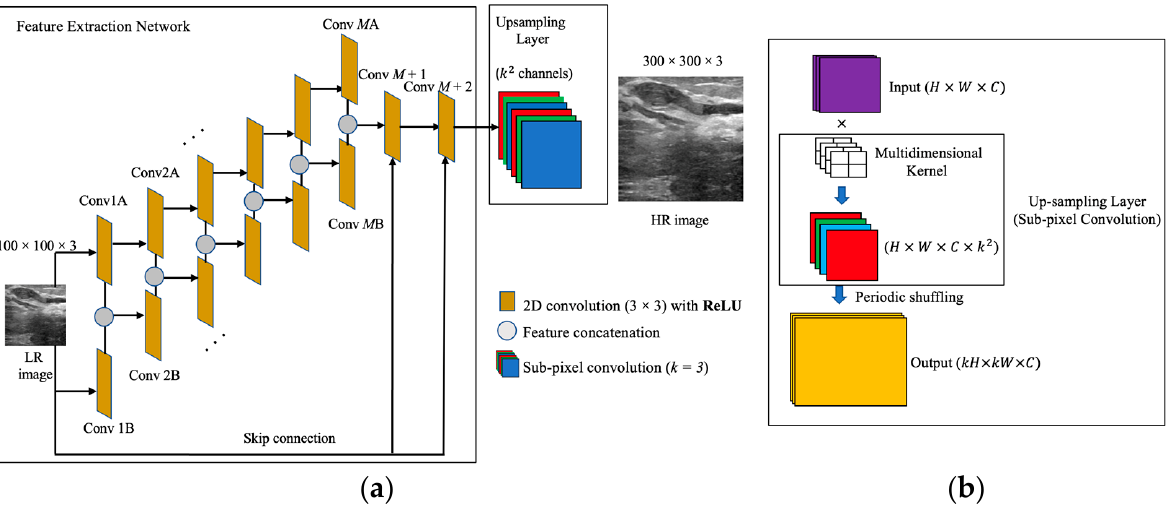
Figure 1. Schematic representation of the SS-CNN model. ( a ) Feature extraction network, and ( b ) Up-sampling layer.